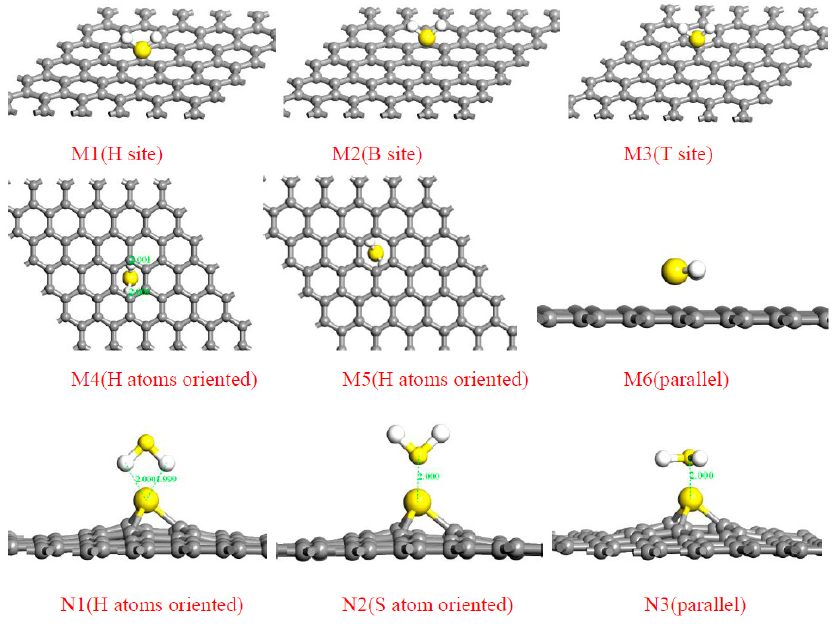
Figure 5. Adsorption configurations of H 2 S on pristine (M1~M6) and Au graphene surfaces (N1~N3). Reproduced with permission from [57]. Copyright 2016 Applied surface science. Table 1. Adsorption energies of H 2 S on pristine graphene and Au-graphene. Reproduced with permission from [57]. Copyright 2016 Applied surface science.